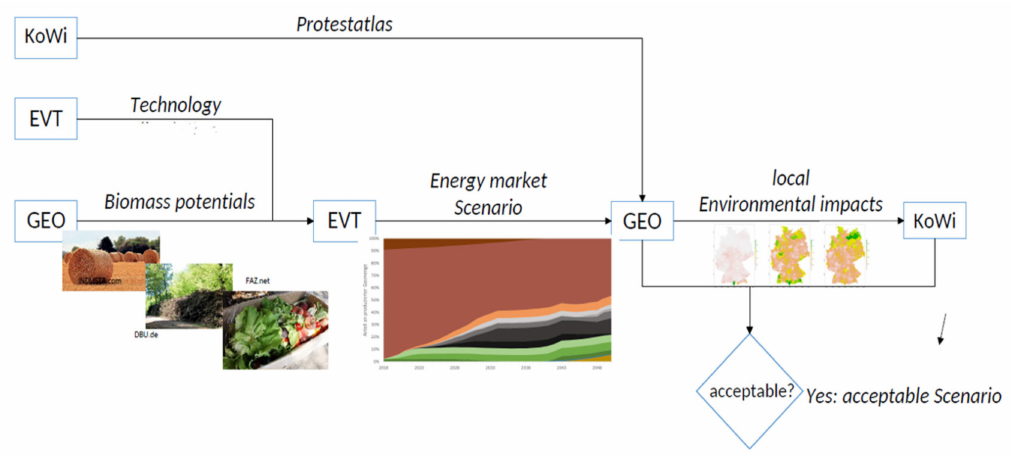
Figure 1. Project workflow showing each partner’s responsibility at a